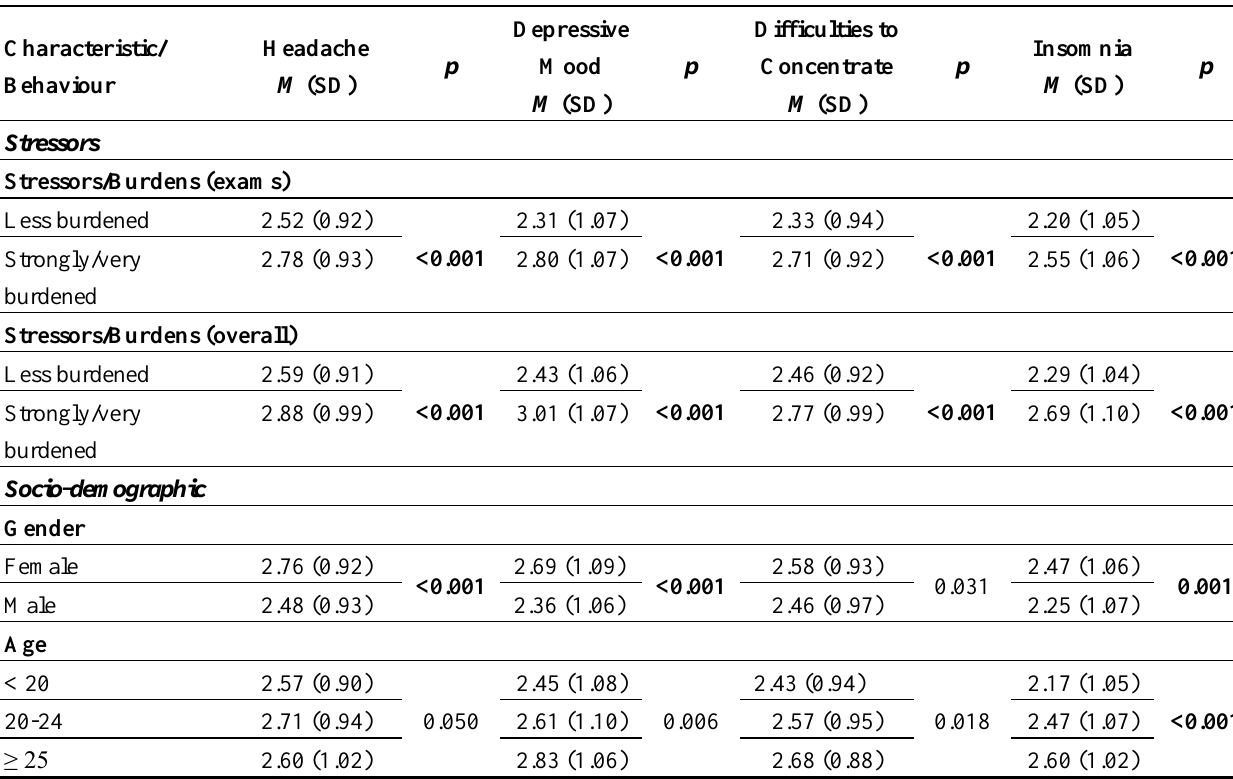
Table 4. Frequency of symptoms by general characteristics and by health